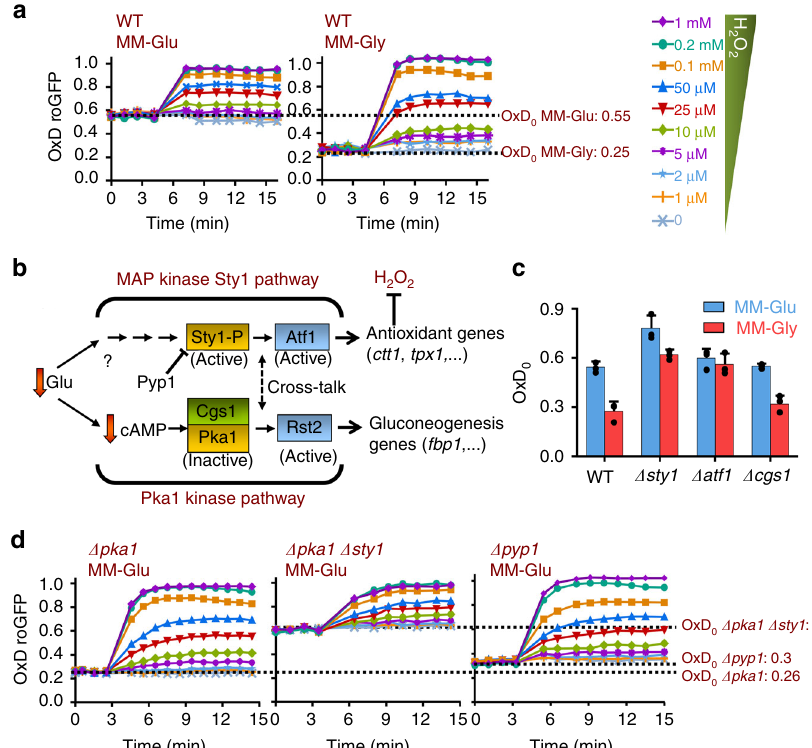
Fig. 6 Effect of low-glucose media on roGFP2-Tpx1.C169S oxidation. a Strain HM123 transformed with p407.C169S was grown in MM-Glu or MM-Gly (respiratory-prone conditions), and H 2 O 2 treatments were performed and oxidation of the reporter estimated as described in Fig. 1. Data from three biological replicates are shown, with error bars (S.D.) displayed in Supplementary Fig. 8a. b Scheme depicting the effect of glucose deprivation in the activation and inactivation of the Sty1 and Pka1 kinases, respectively. Activation of the Sty1 pathway triggers the transcription of Atf1-dependent antioxidant genes such as ctt1 or tpx1 . Inactivation of the Pka1 kinase results in the de-repression of gluconeogenic genes and upregulation of mitochondrial oxygen consumption. The Pyp1 phosphatase is a negative regulator of the Sty1 kinase. c Strains HM123 (WT), EP16 ( Δ sty1 ), EP193 ( Δ atf1 ), and ED1150 ( Δ cgs1) were transformed with plasmid p407.C169S and basal OxD 0 levels determined as described in Fig. 1. Data from three biological replicates with error bars (S.D.) and individual data points overlaid (black dots) are shown. d Strains MC22 ( Δ pka1 ), MC24 ( Δ pka1 Δ sty1 ), and AZ64 ( Δ pyp1 ) were transformed with plasmid p407.C169S and H 2 O 2 treatments were performed and oxidation of the reporter estimated as described in Fig. 1. Data from three biological replicates are shown, with error bars (S.D.) displayed in Supplementary Fig.